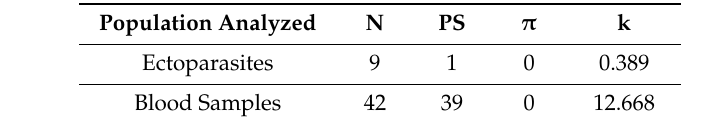
Table 2. Polymorphism found within each sample population (ectoparasite and bat blood samples) for gltA Bartonella sequences.